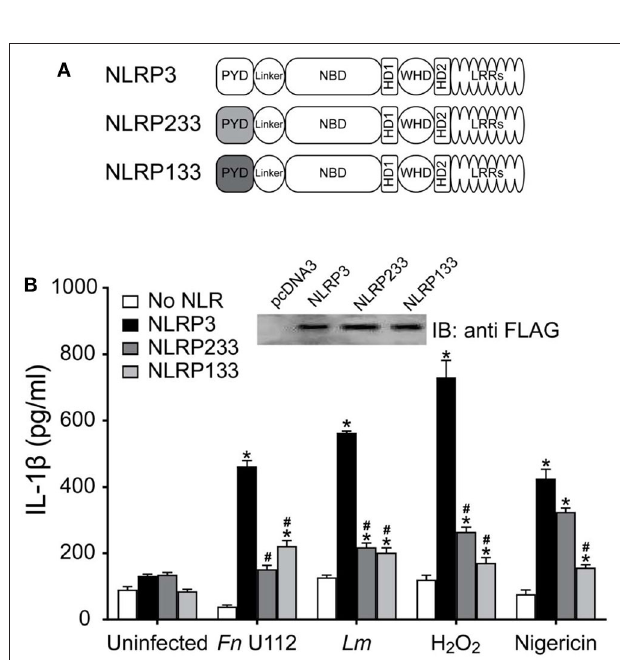
FIGURE 5 | The PYD domain of NLRP3 is involved in agonist sensing. (A) Schematic representation of N-terminal PYD substitution mutants. (B) IL-1 β response of HEK293T cells expressing ASC, pro-Caspase-1, pro-IL-1 β , and NLRP3, or the indicated PYD substitution mutants stimulated by infection with Fn U112 (MOI 100) or L. monocytogenes (Lm) (MOI 20) or treated with 100 µ M H 2 O 2 or 5 µ M nigericin. Supernatant IL-1 β was measured by ELISA. Data represent the mean ± SEM for at least three independent experiments * p < 0.0001 for comparison with respective untreated controls; # p < 0.0001, twoway ANOVA followed by Dunnett’s multiple comparison tests. (Inset) FLAG-tagged NLRP3 and N-terminal PYD substitution mutants expressed in HEK293T cells, 10 µ g total protein was separated by SDS-PAGE (10%) and immunoblotted with anti-FLAG